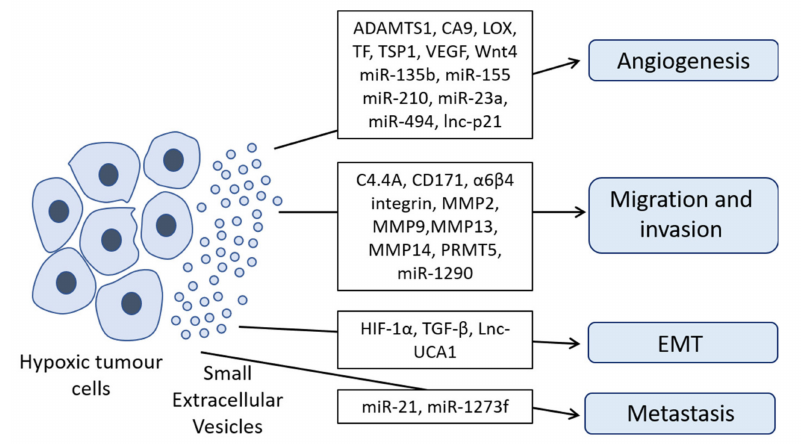
Figure 2. Hypoxic sEVs promote progression and metastasis of cancer cells. Hypoxic sEVs enriched with a disintegrin and metalloproteinase with thrombospondin motifs 1 (ADAMTS1), carbonic anhydrase 9 (CA9), protein-lysine 6-oxidase (LOX), tissue factor (TF), thrombospondin-1 (TSP1), vascular endothelial growth factor (VEGF), Wnt4, miR-135b, miR-155, miR-210, miR-23a, miR-494 and / or lnc-p21 promote angiogenesis. Hypoxic sEVs loaded with C4.4A, CD171, α 6 β 4 integrin, matrix metalloproteinases (MMP2, MMP9, MMP13 and MMP14), protein arginine methyltransferase 5 (PRMT5) and / or miR-1290 drive migration and invasion of target cancer cells. HIF-1 α , TGF- β and / or Lnc-UCA1 contained in hypoxic sEVs can enhance epithelial to mesenchymal transition (EMT). miR-21 and / or miR-1273f, secreted in hypoxic sEV, promote metastasis of cancer